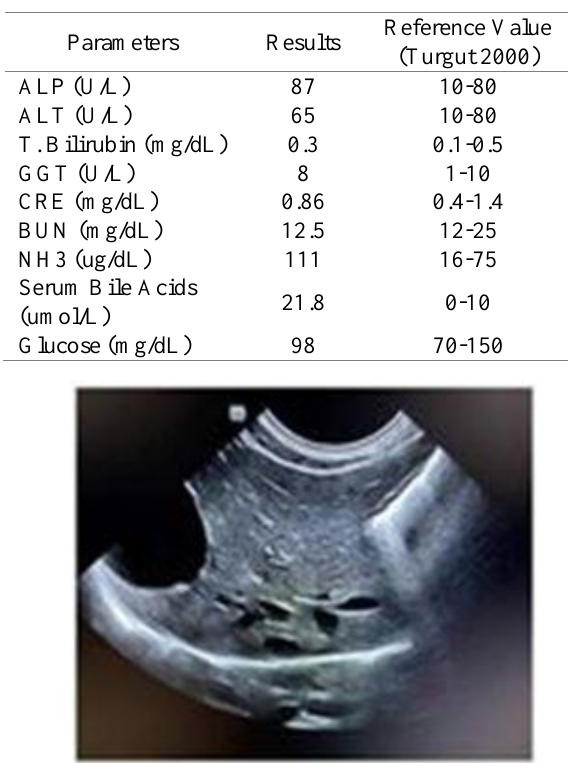
Fig. 1: Portal vein, vena cava caudalis and shunted vessels in